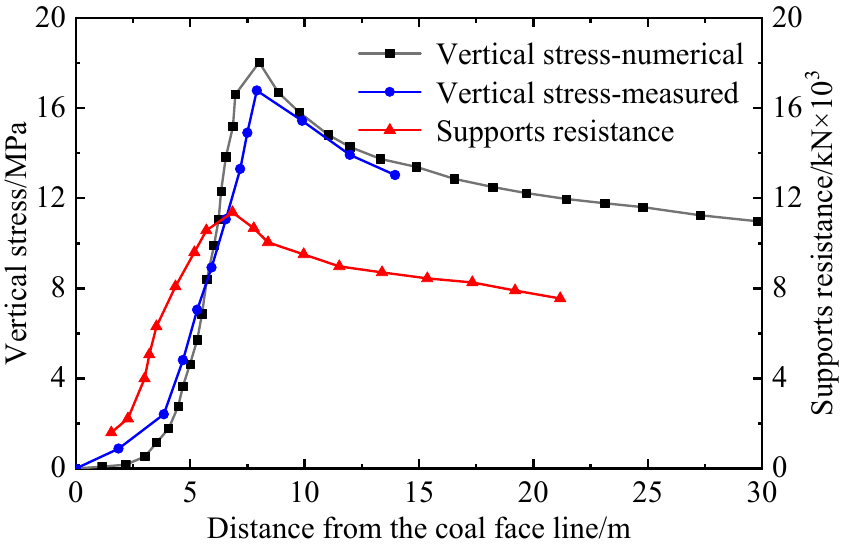
Figure 9. Comparison of vertical stress between measured data and numerical results.